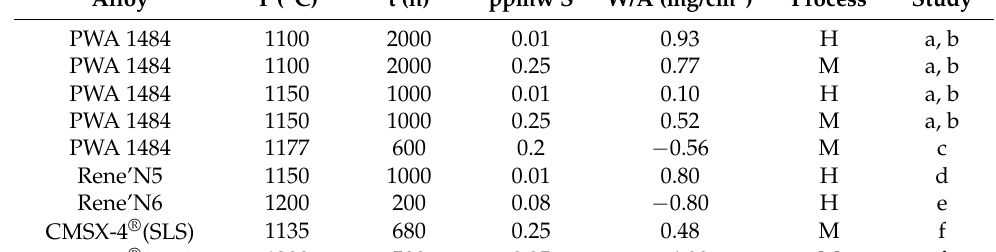
Table 6. Compilation of cyclic oxidation final weight change data for some oxidation-resistant low sulfur 2nd generation single-crystal superalloys (H, hydrogen-annealed; M, melt-desulfurized). a: Smialek 1998 [7], b: Smialek 2002 [13], c: Irvine et al. 1999 [14], d: Smialek, Pint 2001 [11], e: Smith et al. 1995 [15] f: Gray, Harris 2017 [16]. Alloy